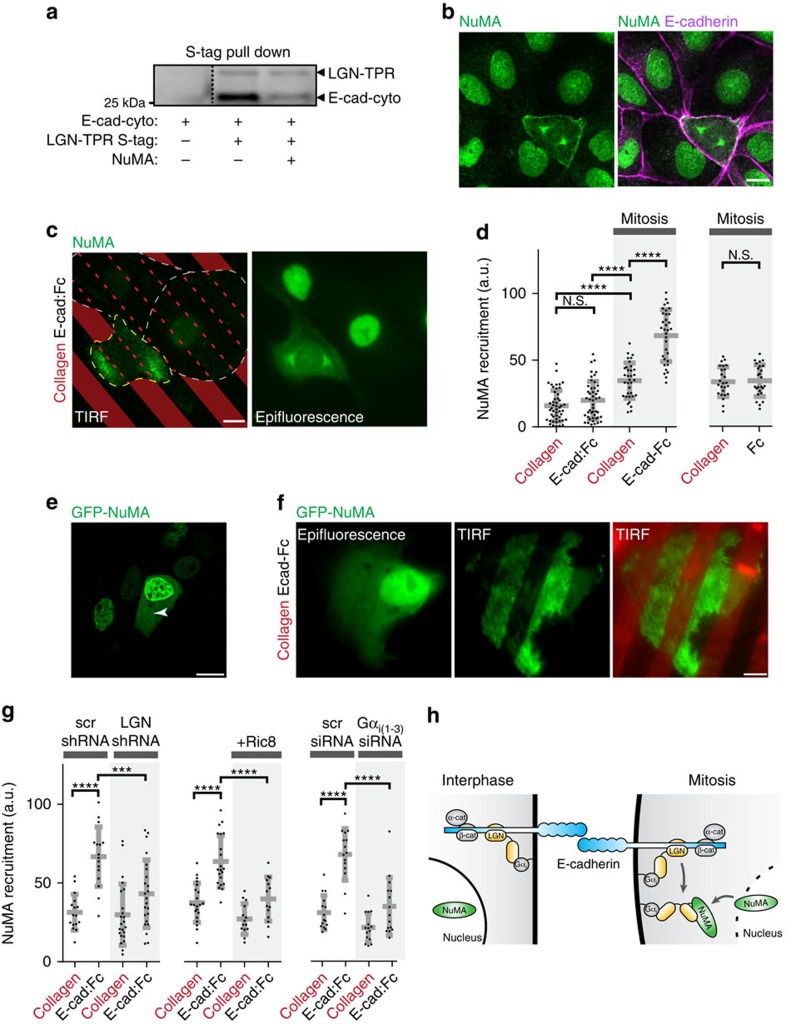
E-cadherin localizes the mitotic LGN/NuMA complex to cell–cell contacts.(a) S-protein agarose pull down of recombinant LGN–TPR and E-cadherin cytoplasmic tail in the presence or absence of NuMA peptide, immunblotted for LGN and E-cadherin, showing the competition of E-cadherin cytosolic tail from LGN–TPR:S-tag by the LGN-binding domain of NuMA. (b) Localization of endogenous NuMA and E-cadherin in interphase and mitotic MDCK cells. (c) TIRF and epifluorescence microscopy of NuMA in MDCK cells plated on micro-patterned alternating stripes of collagen-IV/E-cad:Fc. Cells are outlined in yellow (mitotis) and grey (interphase), for increased clearness stripes are shown as projections in the TIRF image. (d) Quantification of NuMA fluorescence intensity at the plasma membrane bound to stripes coated with different proteins in interphase and mitotic cells. (e) Cytosolic localization of over-expressed GFP-NuMA in interphase MDCK cells, showing its cytosolic accumulation (marked with an asterisk) in cells with high expression. (f) Localization of GFP-NuMA on MDCK cells plated on collagen-IV/E-cad:Fc micro-patterned surfaces visualized by TIRF microscopy. (g) Quantification of NuMA fluorescence intensity at the plasma membrane bound to different stripes in mitotic cells on shRNA-mediated depletion of LGN, disruption of LGN/Gαi interactions by overexpression of Ric8, or on expression of siRNAs targeting Gαi1, Gαi2 and Gαi3. Representative images and epifluorescence of NuMA localization in LGN shRNA monolayers are shown in Supplementary Fig. 4a–4c. (h) Model for localization of the LGN/NuMA complex to cell–cell contacts by E-cadherin. By interacting with the cytosolic tail of E-cadherin, LGN is recruited to cell–cell contacts in interphase. After nuclear breakdown during mitotic entry, NuMA is released from the nucleus and competes LGN from the E-cadherin/LGN complex. The locally formed LGN/NuMA complex remains at E-cadherin adhesions through the interaction of LGN with Gαi. Scale bars, 10 μm; all quantified data were pooled from three independent experiments; grey bars in dot plots show mean±s.d.; ****P<0.0001; ***P=0.0002, N.S.=not significant, using unpaired student t-test.